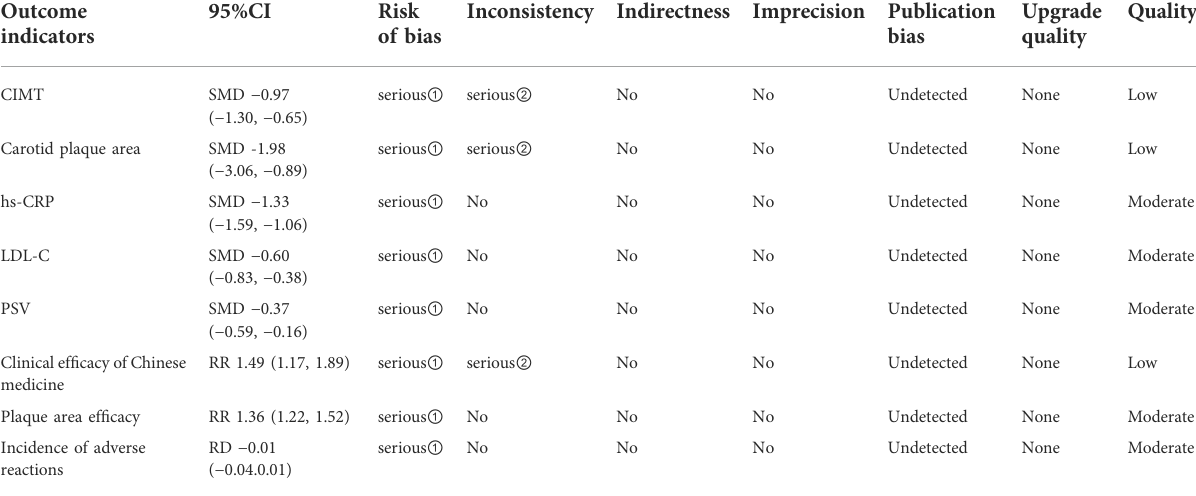
TABLE 3 Evaluation of GRADE evidence